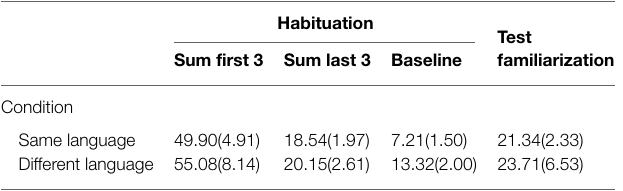
TABLE 1 | Mean looking times and standard errors for the habituation, baseline, and familiarization phases for each condition.